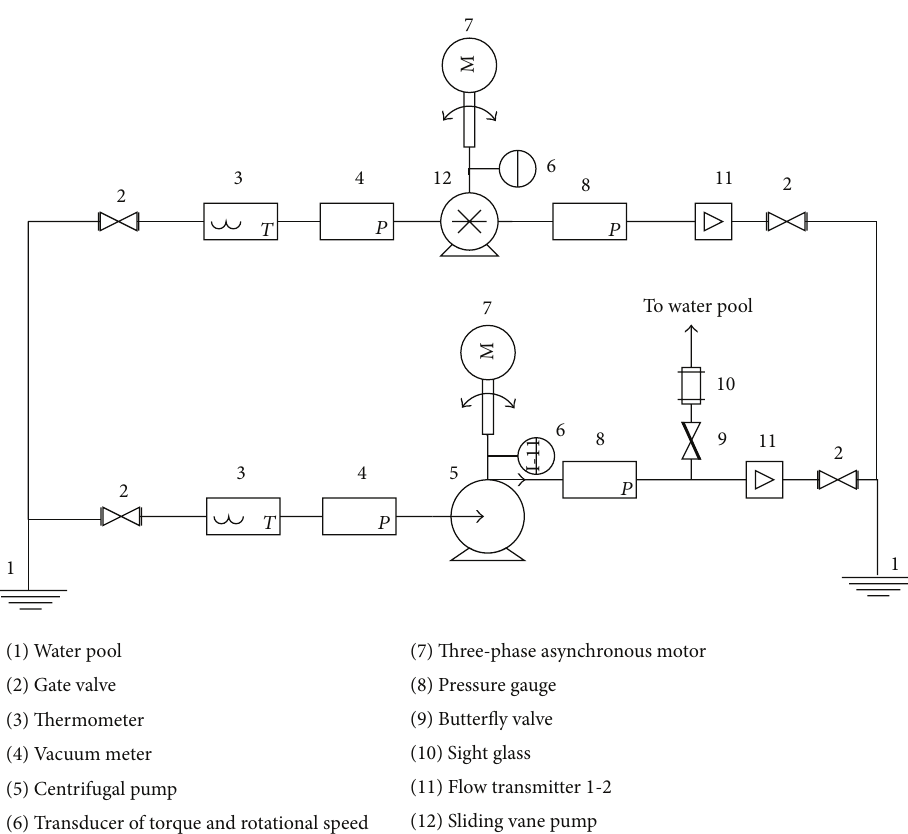
Figure 1: Flowchart of the independent operation of sliding vane pump and centrifugal pump.